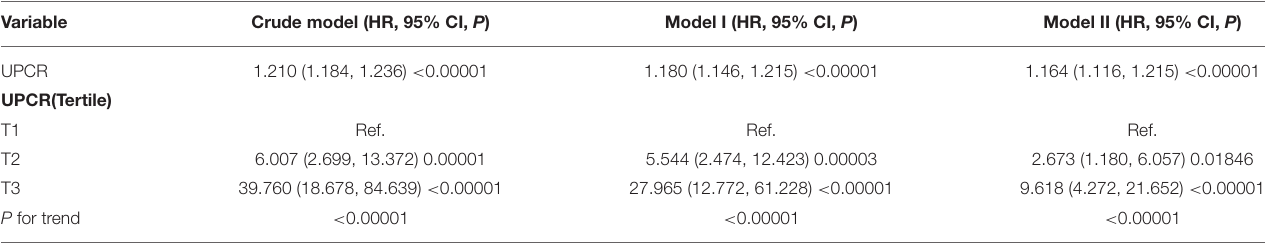
TABLE 4 | Relationship between UPCR and the chronic kidney disease progression in different models. Variable